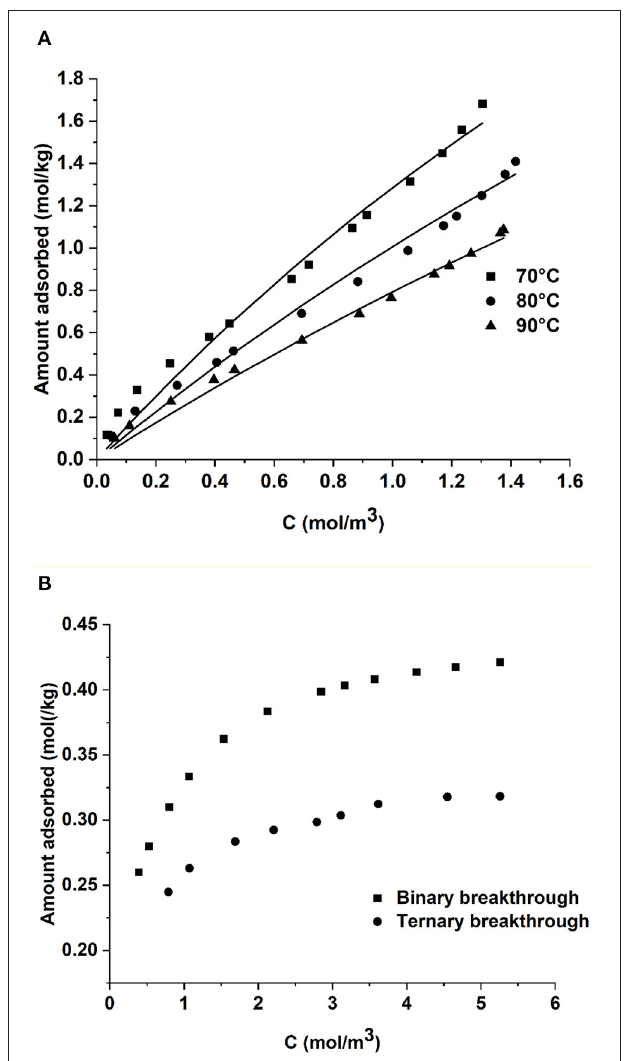
FIGURE 10 | (A) H 2 O adsorption isotherms in the 3D printed sorbent and (B) adsorption isotherms of CO 2 under binary and ternary conditions. The